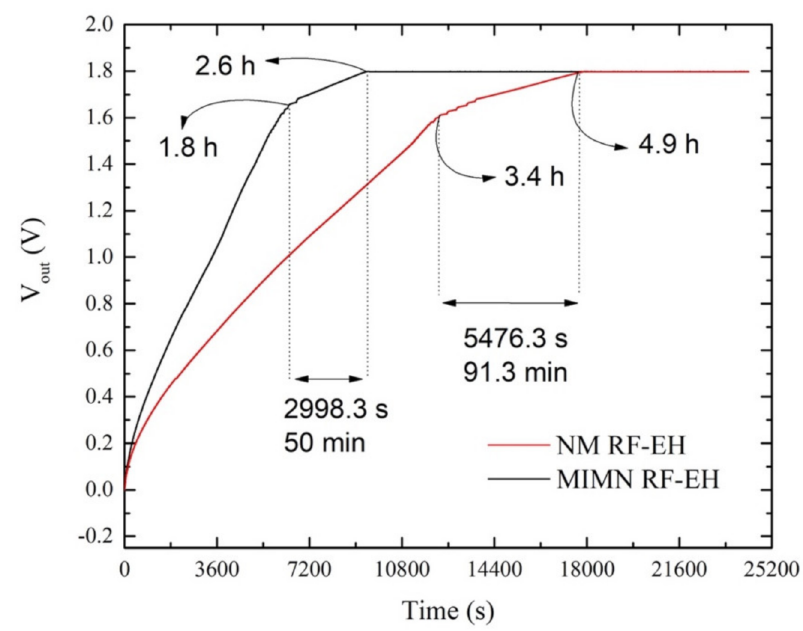
Figure 10. EMS output voltage (V out in Figure 7) using a 6.8 mF supercapacitor as output storage element. The evolution between 0 and 1.6 V corresponds to the cold state. V out exhibits a linear behavior in the range 1.6 V < V out < 1.8